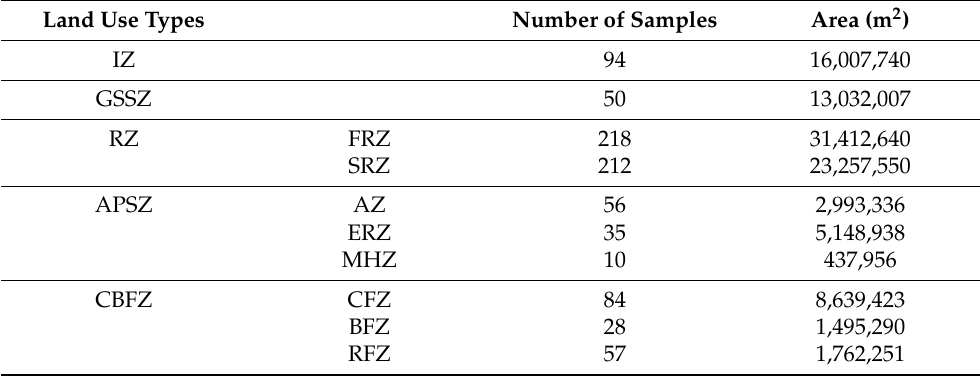
Figure 3. Land use classification of the study area: ( a ) land use classification of the first category; ( b ) percentage statistics of land use in the first category; ( c ) percentage statistics of ground cover in the first category of land use; ( d ) land use classification of the second category; ( e ) percentage statistics of land use in the second category; ( f ) percentage statistics of ground cover in the second category of land use. Table 2. Statistics of sample size and regional